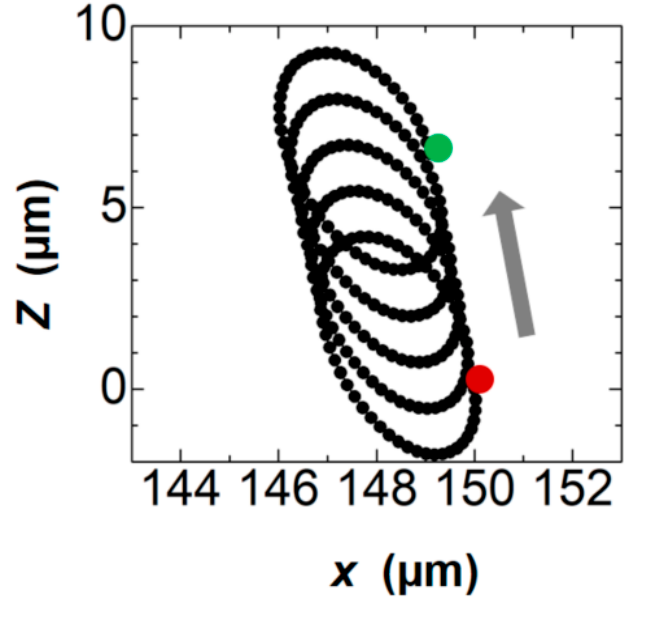
Figure 6. A 2D trajectory of a particle during five rotations.